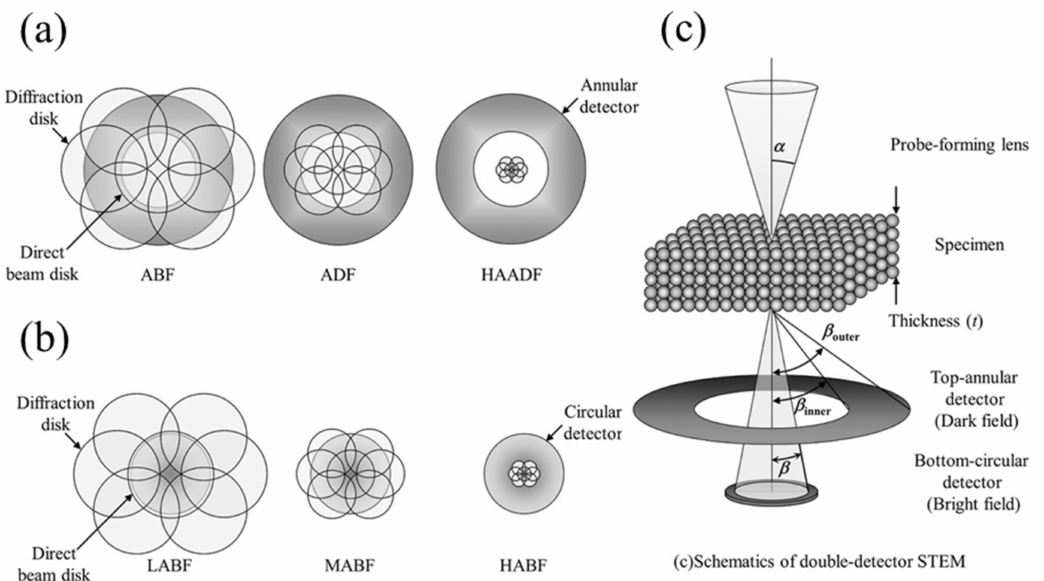
Figure 9. Schematic configuration of STEM detection set-up. ( a ) annular DF (ADF) detector under ABF, ADF and HAADF conditions; and ( b ) circular BF detector under LABF, MABF, and HABF conditions. The camera length is shortened in the order of ABF, ADF, HAADF in DF-STEM imaging, and LABF, MABF, HABF in BF-STEM imaging. ( c ) Schematic diagram of double-detector STEM imging. The top annular detector and the bottom circular detector are placed with a separating distance [117]. Figure 9 reprinted from Applied Physics Letters, 101, Yasutoshi Kotaka, Direct visualization method of the atomic structure of light and heavy atoms with double-detector Cs-corrected scanning transmission electron microscopy, 133107, Copyright (2012), with permission from AIP Publishing.